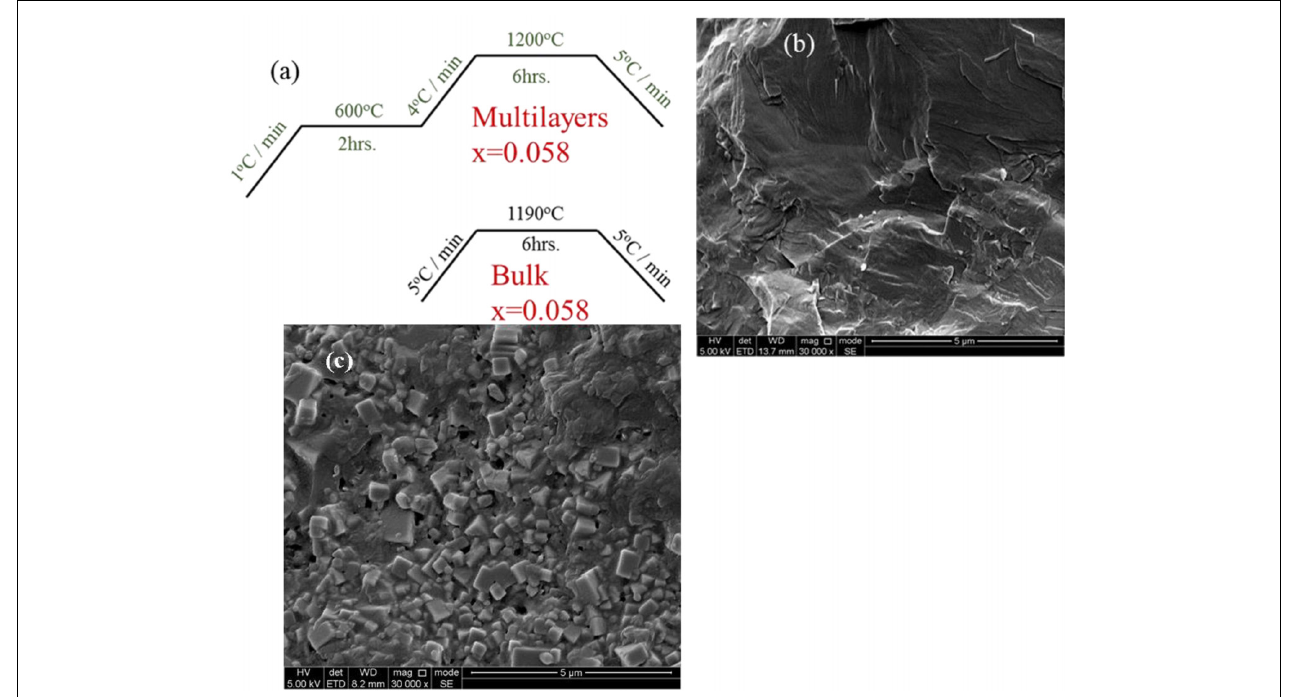
FIGURE 2 | (a) Heat treatment and sintering profile of MLAs and bulk Ceramics, and (b) SEM images of fractured surfaces of bulk, and (c) single layer of multilayers of (0.942KNN–0.058BNZ) +ZrO 2 ceramics. TABLE 1 | Comparisons of general properties per layer (bulk) with well-established commercial type piezoelectric Ceramics. Piezoelectrics d 33